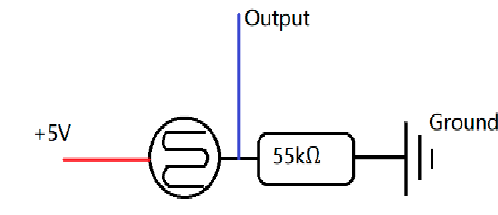
Figure 9. Typical performance of PDV-P8103.